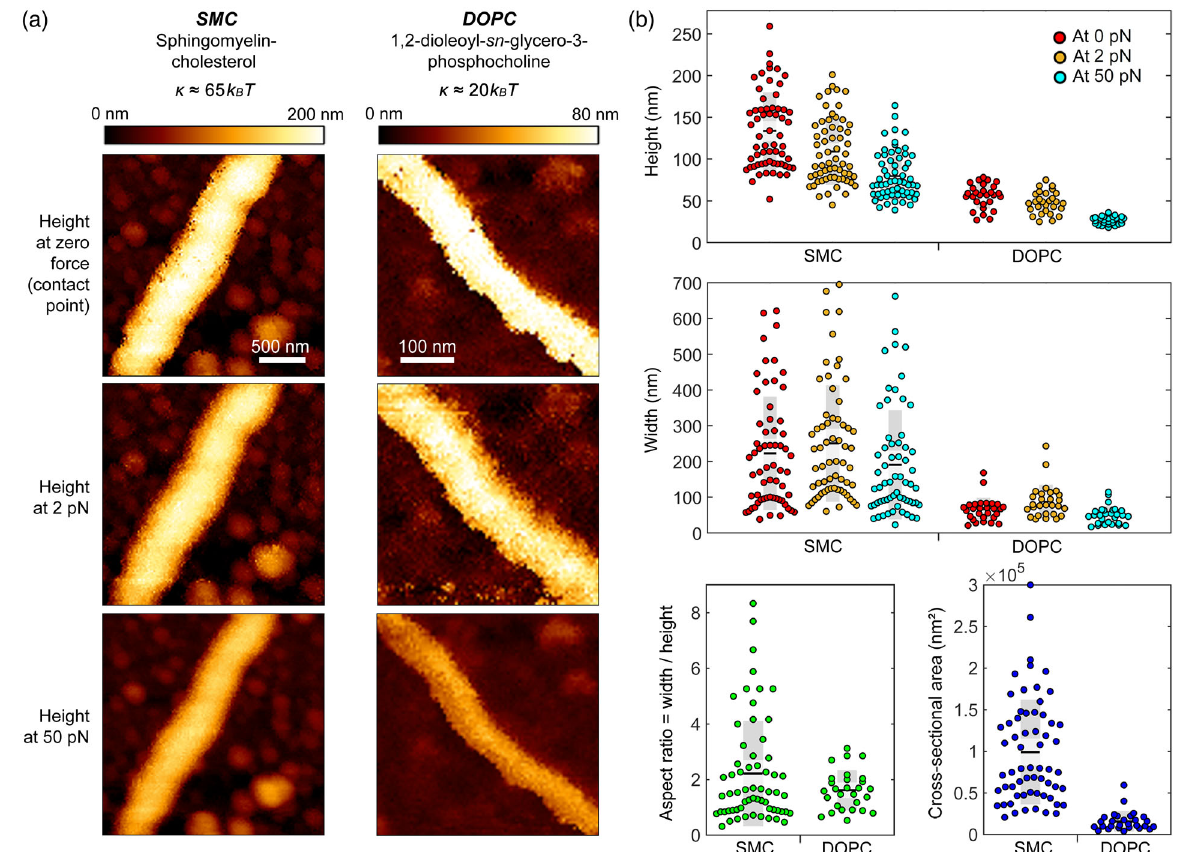
FIG. 4. High-throughput probing of nanotube morphologies by AFM. (a) Examples of QI mode AFM images collected for nanotubes with two different lipid compositions, resulting in different rigidities. The bending rigidities κ listed here were independently determined for lipid bilayers in vesicles at room temperature [32,33]. Force curves were collected, and the heights measured at forces of 0, 2, and 50 pN are reported in separate images. (b) From top to bottom: heights, widths, aspect ratios, cross-sectional areas of all nanotubes ( N ¼ 62 for SMC and N ¼ 28 for DOPC). Aspect ratios and cross-sectional areas are calculated using the height at 0 pN and the width at 2 pN (see Sec. VI for details). Black horizontal lines and gray boxes represent the mean plus or minus 1 standard